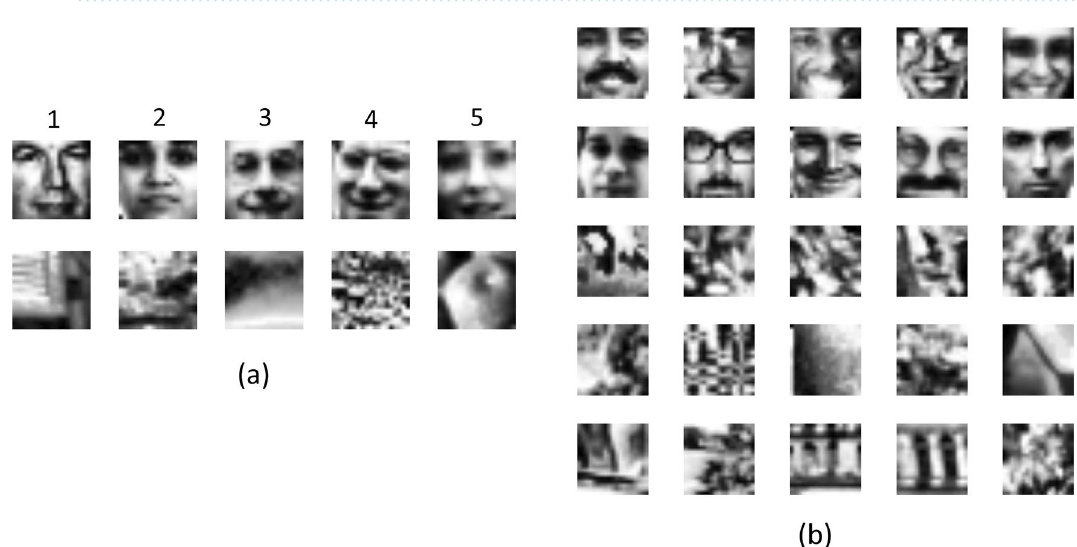
Figure 7. Results of the template similarity measurement. The top row indicates the average image of all faces belonging to a certain number of correct features. The number of correct features is indicated by the numbers on top of each image, i.e., each column corresponds to one correct feature category. The bottom row shows the average image of all distractors belonging to such a category. Interestingly, the average image of all distractors with 12 correct features resembles a face, whereas the average image of all distractors with only 1 correct feature resembles an inverted face.